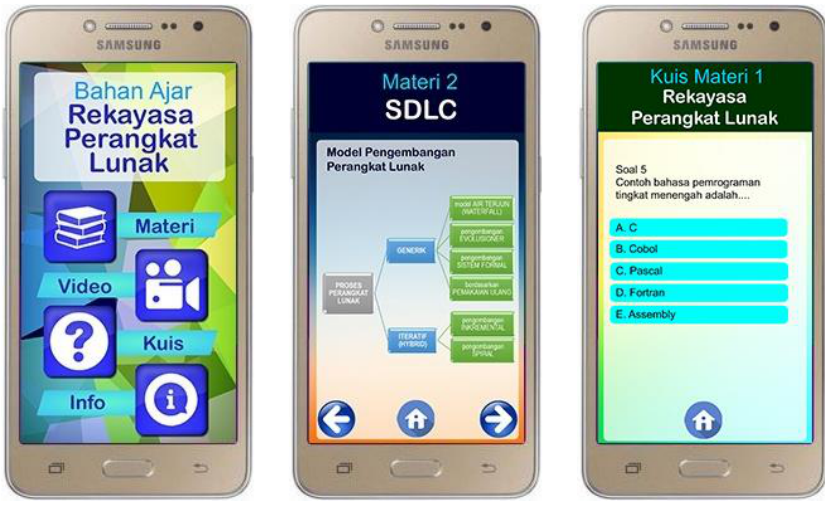
Fig. 3. Screenshot of Android-Based Teaching Material, from left to right: home menu, material display, and menu quiz display (Source: output of development